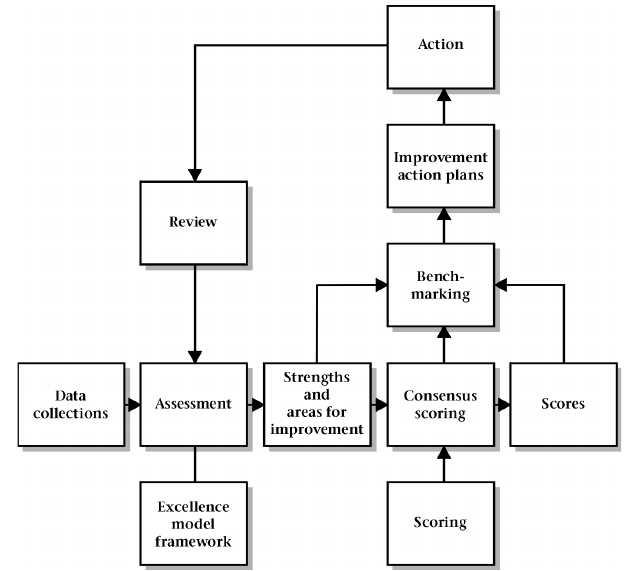
Figure 2: Integrated excellence model